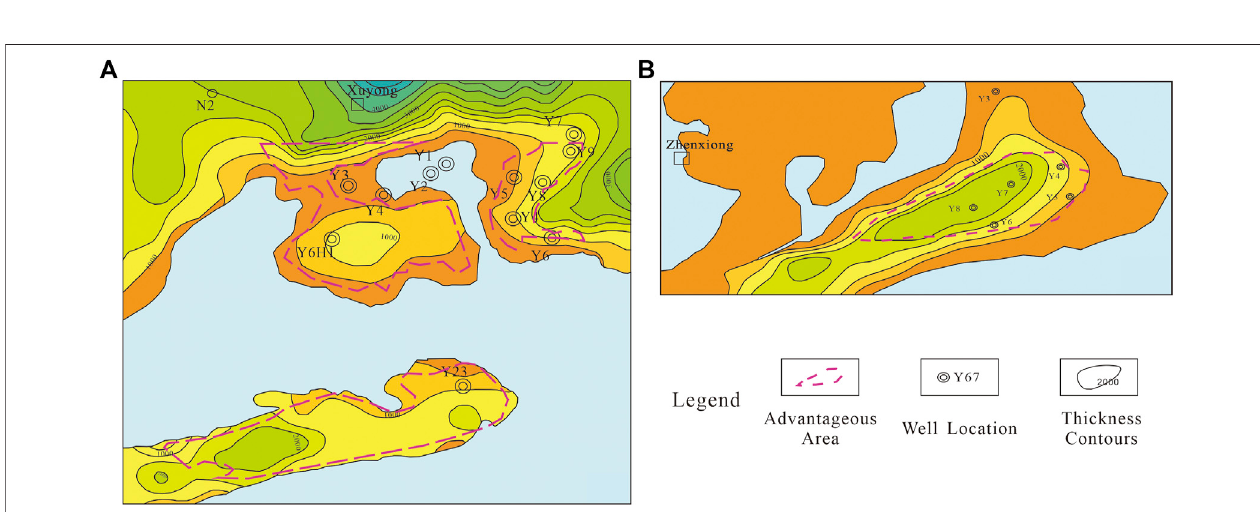
FIGURE 10 | Distribution and resource quantity of transitional shale gas favorable areas in Leping Formation of the study area.